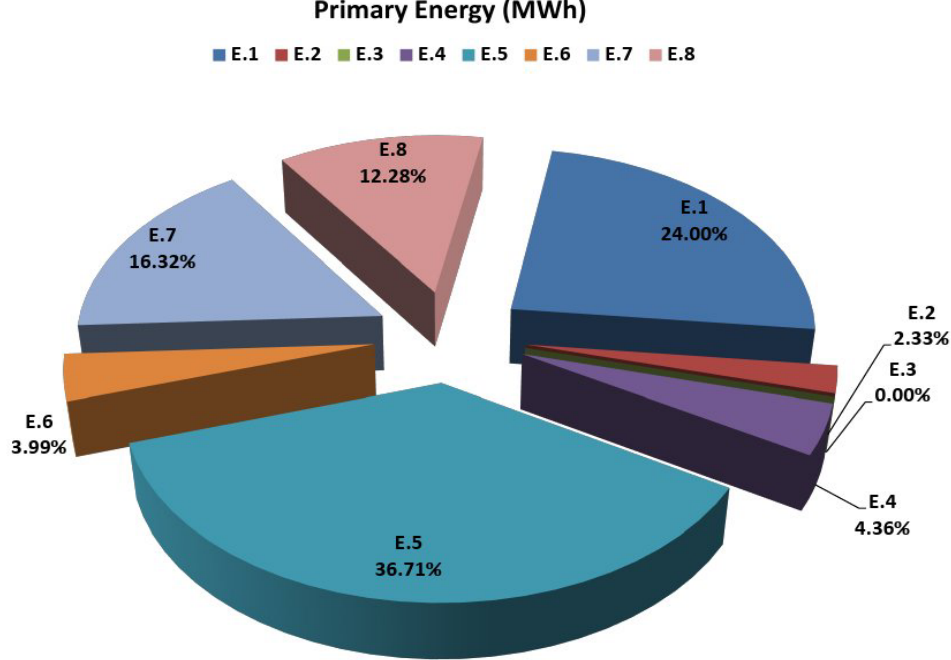
Figure 1. Primary energy by building energy use, excluding E:5 shopping